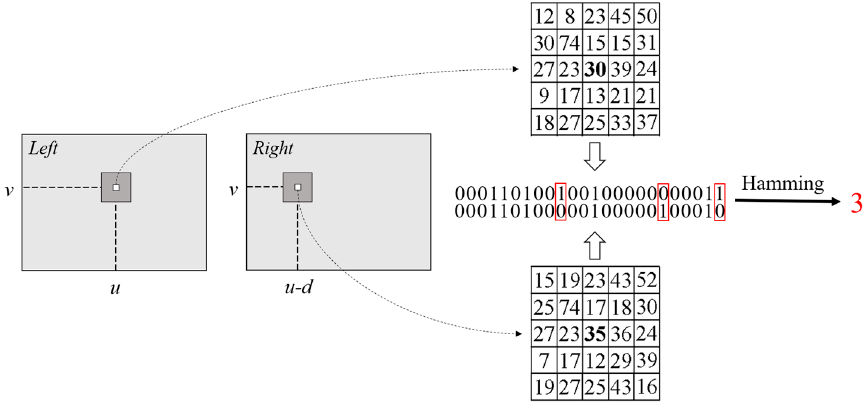
Figure 2. Schematic diagram of census transform.